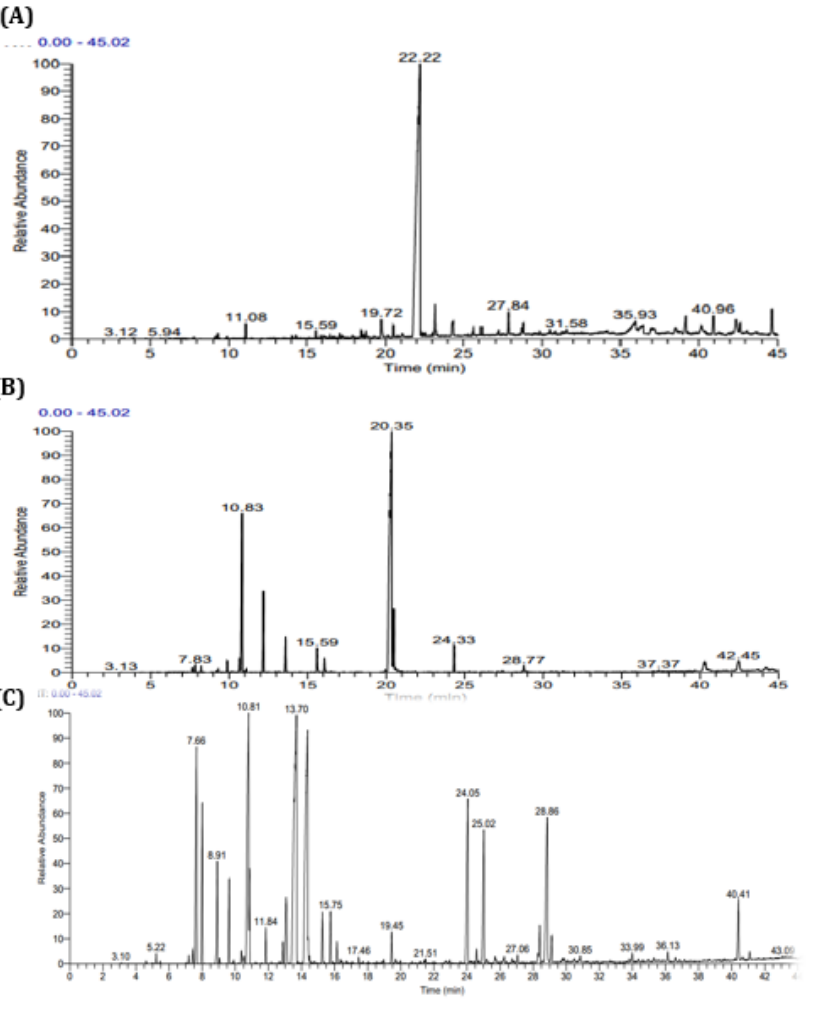
Figure 1. Chromatogram of M. suaveolens Ehrh. ( A ), T. zygis L. ( B ), and S. officinalis L. ( C ) EOs. Table 2. Chemical composition of the EOs of T. zygis L., S. officinalis L. and M. suaveolens Ehrh. RT Constituents